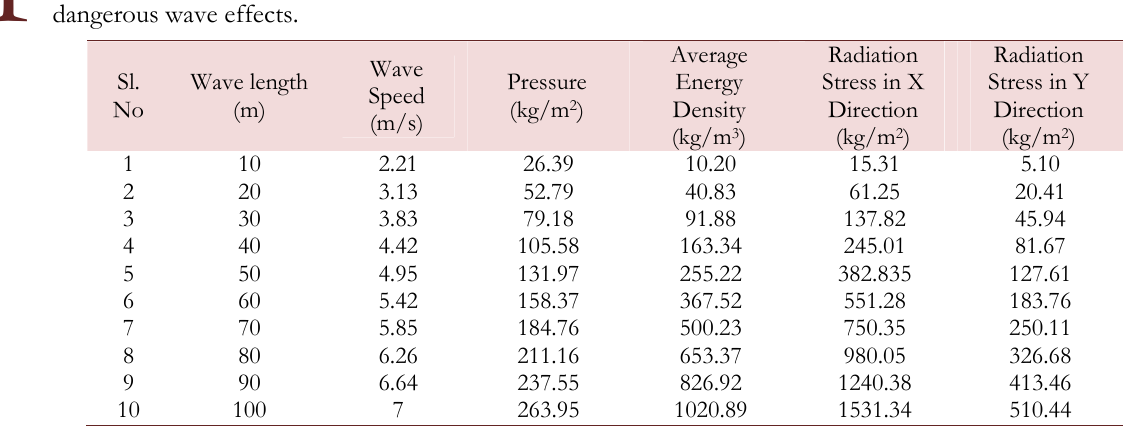
Table 1: Mathematical Characteristics of Wave in Shallow